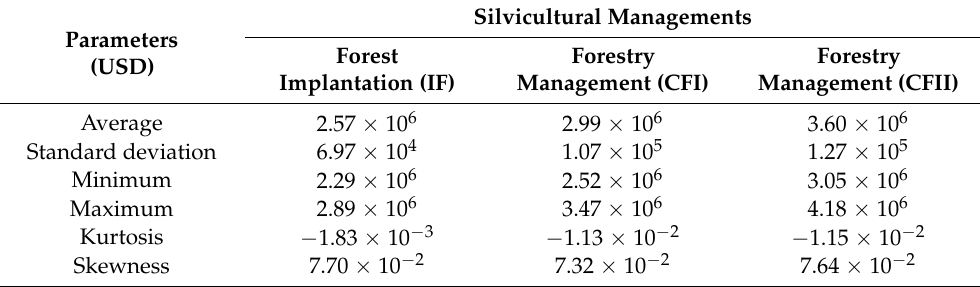
Table 3. Descriptive statistics of the Monte Carlo simulation for the investment projects of the three consecutive rotations, with the price of Eucalyptus wood following the geometric Brownian motion.